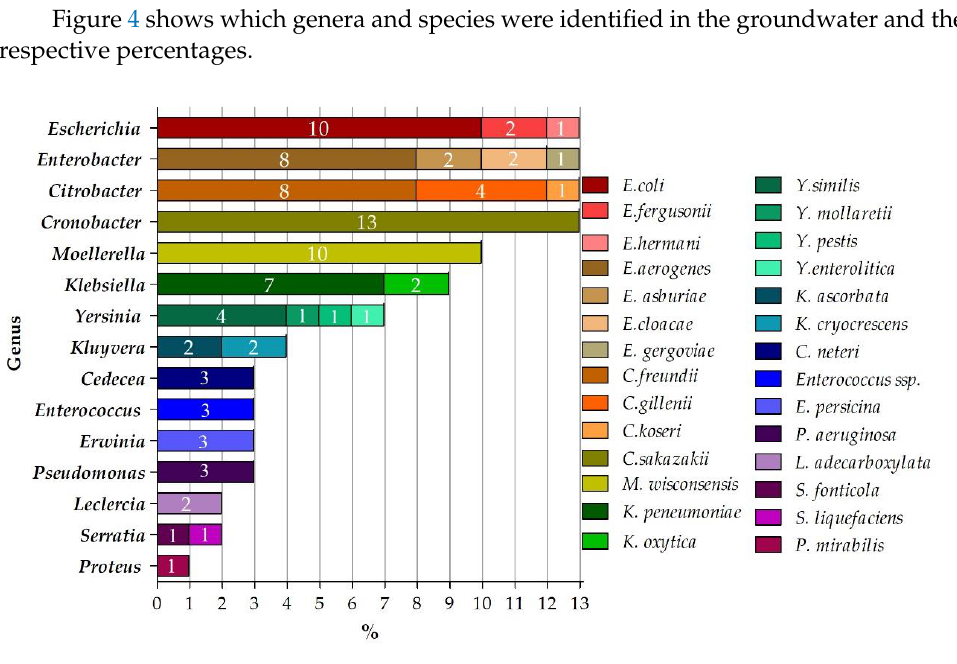
Figure 4. Distribution (%) of genera and species of bacteria in groundwater in Porto Velho, RO. Fifteen genera were identified in the groundwater in Porto Velho. Four of the fif- teen were dominant: Escherichia, Enterobacter, Citrobacter and Cronobacter . Each made up 13% of the total bacteria. These were followed by the genera Moellerella, Klebsiella and Yersinia , at 10%, 9% and 7%, respectively. The frequencies of all other genera were below 4%. In total, 27 species were identified. Cronobacter sakasakii was the most